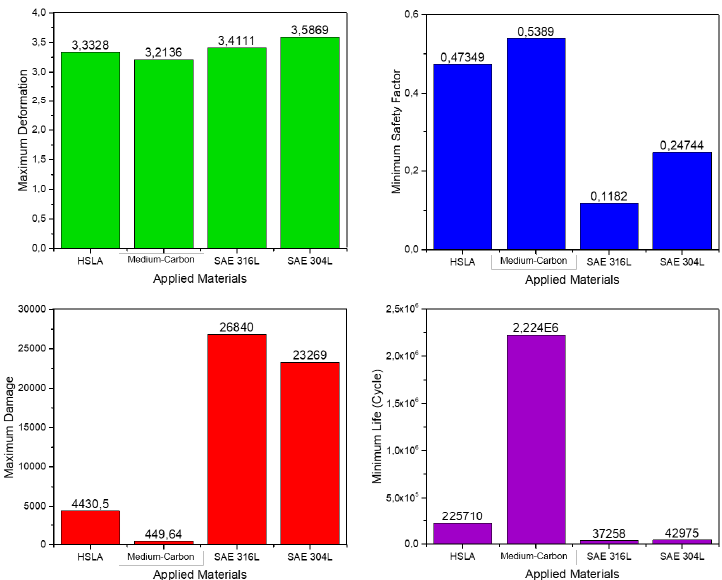
Figure 21. Fatigue Results: Maximum Deformation, Minimum Safety Factor, Maximum Damage, and Minimum Life for Each Material Used Figure 21: Fatigue results: Maximum deformation, minimum safety factor, maximum damage, and minimum life for each material used